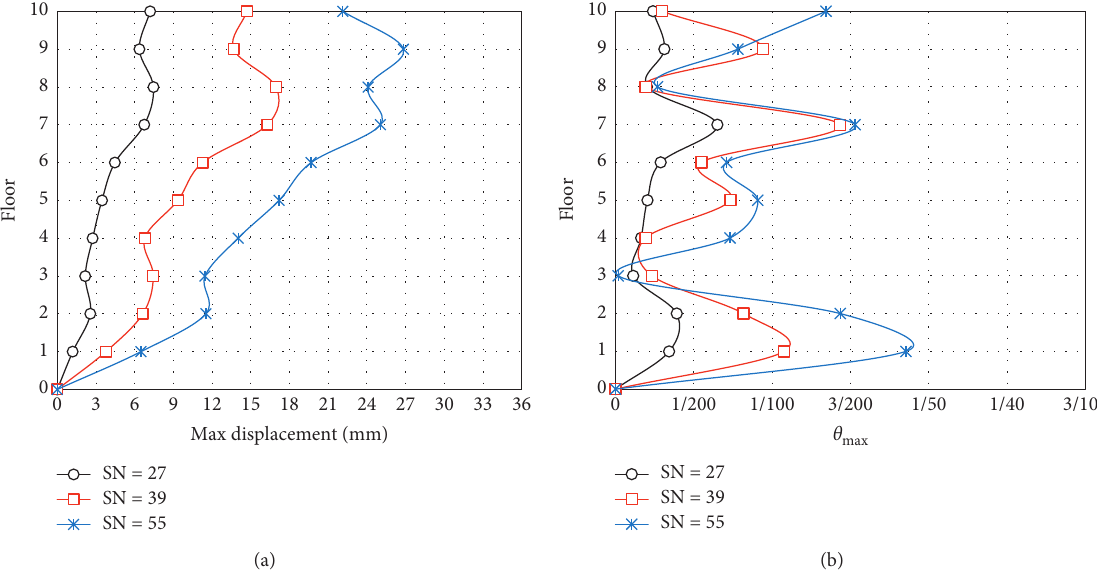
Figure 26: Envelope diagrams of the displacement response under the Shanghai earthquake. (a) Maximum layer displacement. (b) Interstory drift